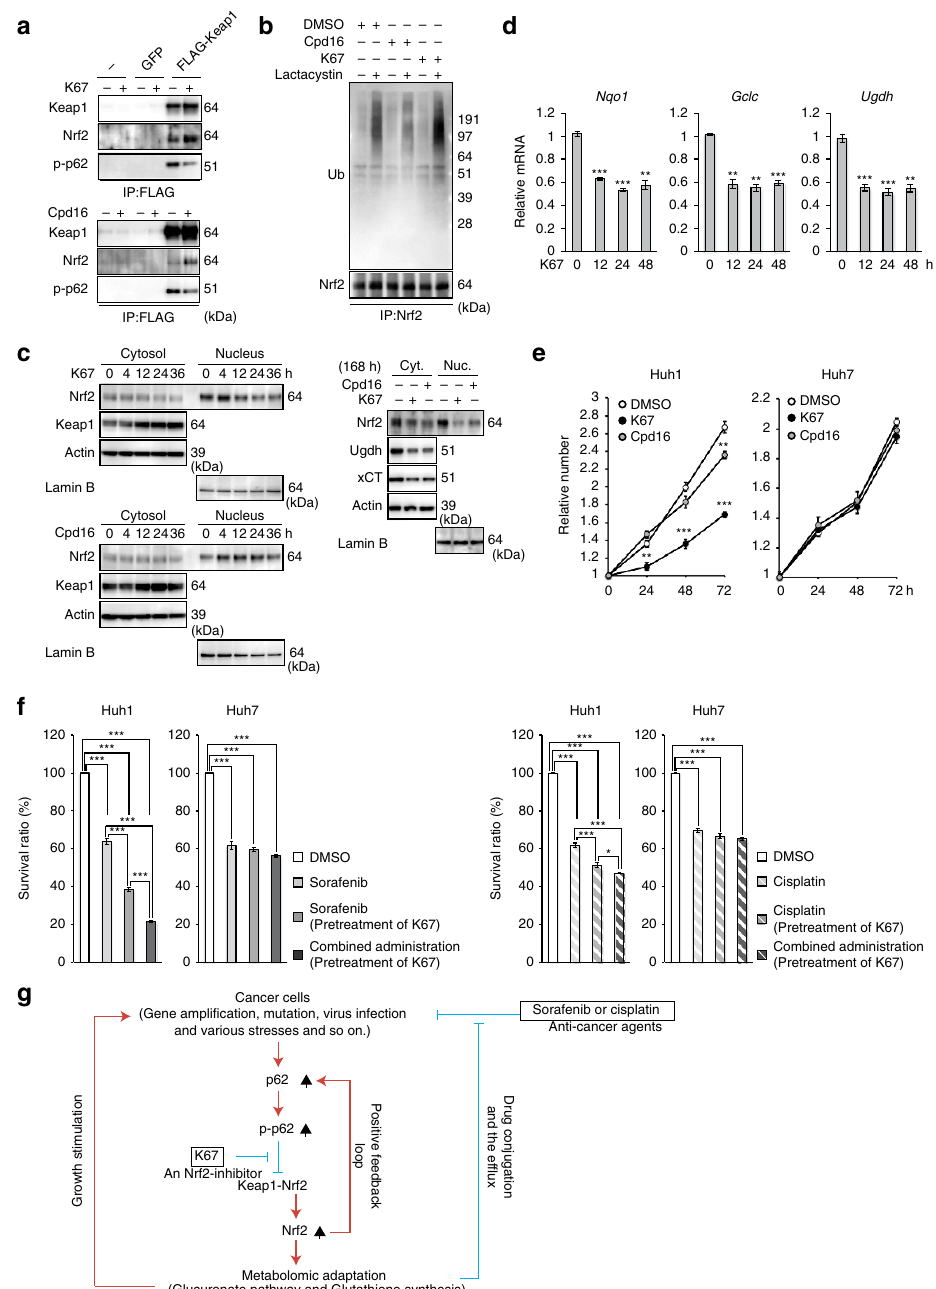
Figure 10 | Inhibitory effects of K67 on tumour growth and tolerance to anti-cancer agents. ( a ) Immunoprecipitation assays. Huh1 cells expressing FLAG-Keap1 were cultured in the presence or absence of indicated compound (50 m M) for 12h. The immunoprecipitant with anti-FLAG antibody was subjected to immunoblot analysis. Experiments were performed three times. ( b ) Ubiquitination of Nrf2. Huh7 cells expressing S351E were cultured in the presence or absence of indicated compound (50 m M). After 4h of treatment, the cells were treated with or without lactacystin (10 m M) for 8h. The immunoprecipitant with anti-Nrf2 antibody was subjected to immunoblot analysis. Experiments were performed three times. ( c ) Immunoblot analysis. Huh1 cells were cultured in the presence of 50 m M K67 or Cpd16 for the indicated times. Cytosolic and nuclear fractions were prepared and subjected to immunoblot analysis. Experiments were performed three times. ( d ) Quantification of mRNA levels of Nrf2 target genes in Huh1 cells treated with 50 m M K67 for the indicated times. Values were normalized to the amount of mRNA in non-treated Huh1 cells. Experiments were performed three times. Data represent means ± s.e. * P o 0.05, ** P o 0.01, *** P o 0.001 as determined by the Welch t -test. ( e ) Effect of K67 on cell proliferation. Huh1 and Huh7 cells were pre-cultured in the presence of DMSO, K67 or Cpd16. Proliferation was measured starting at 72h after pre-culture ( n ¼ 4). Initial cell numbers were normalized to 1. Experiments were performed three times. Data represent means ± s.e. * P o 0.05, ** P o 0.01, *** P o 0.001 as determined by the Welch t -test. ( f ) Effect of K67 on resistance to anti-cancer drugs. Huh1 and Huh7 cells were pre-cultured in the presence of DMSO or K67 for 96h. Thereafter, the cells were treated with sorafenib, cisplatin or either drug in combination with K67 for 48h, and survival ratio was determined ( n ¼ 4). Experiments were performed three times. Data represent means ± s.e. * P o 0.05, ** P o 0.01, *** P o 0.001 as determined by the Welch t -test. ( g ) Schematic diagram of cancer malignancy mediated by the p62–Keap1–Nrf2